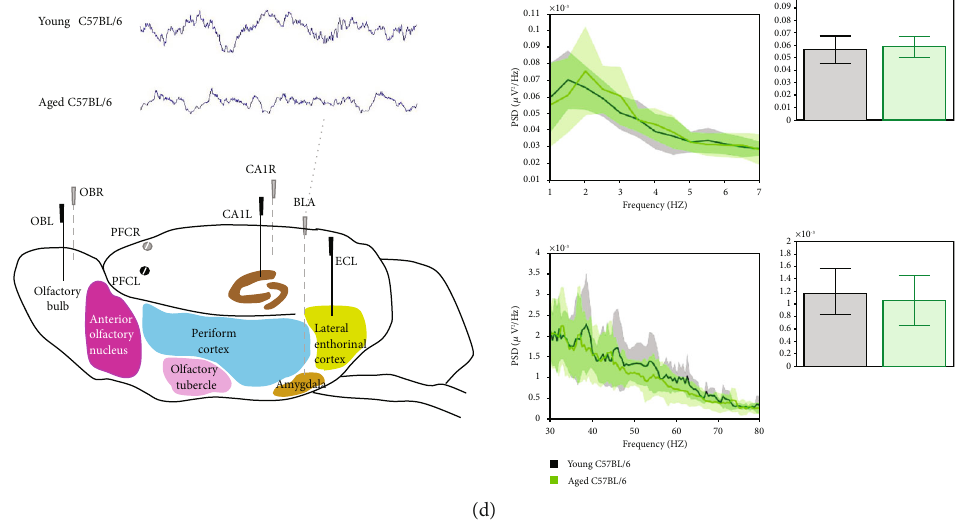
Figure 2: Relative power spectra data of wake LFP signals in low (1-7Hz) and high (30-80Hz left panels) frequencies for recordings performed in left hemisphere. (a) Olfactory bulb (OBL), (b) entorhinal cortex (ECL), (c) hippocampal CA1 (CA1L), and (d) basolateral amygdala (BLA) for young (black, n = 7 ) and aged (green, n = 8 ) C57BL/6 mice. Data are presented as mean values ± 95 % confidence intervals for young (black, n = 7 ), and aged C57BL/6 mice (green, n = 8 ). Bars on the horizontal axis indicate clusters, which drive signi fi cant between group di ff erences using threshold-free cluster enhancement (TFCE, α = 0 : 05 ). Right bar and whiskers panels show relative power in delta frequency 1-4 Hz (top) and gamma frequency 30-80 Hz (bottom). Lines above bar plots with asterisks indicate presence of signi fi cant between group di ff erence, ∗ p value < 0.05 (two-sample t -test), ∗ p value <